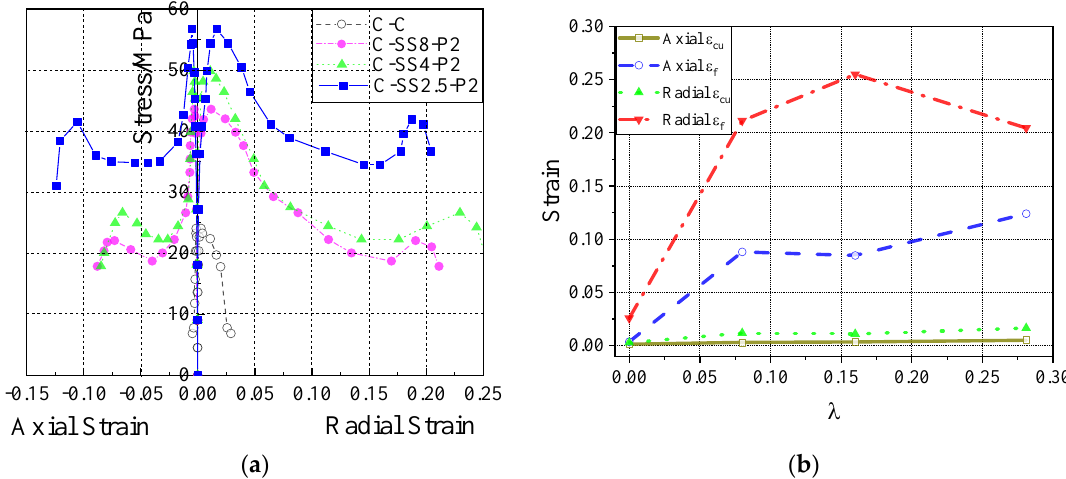
Figure 8. Axial stress–strain relation comparison of concrete cylinders with different reinforcement amount of SMA wires: ( a ) Axial stress–strain curves of concrete cylinders with different reinforcement amount of SMA wires; ( b ) Comparison of axial and lateral peak strain and failure strain of concrete cylinders with different reinforcement amount of SMA wires.